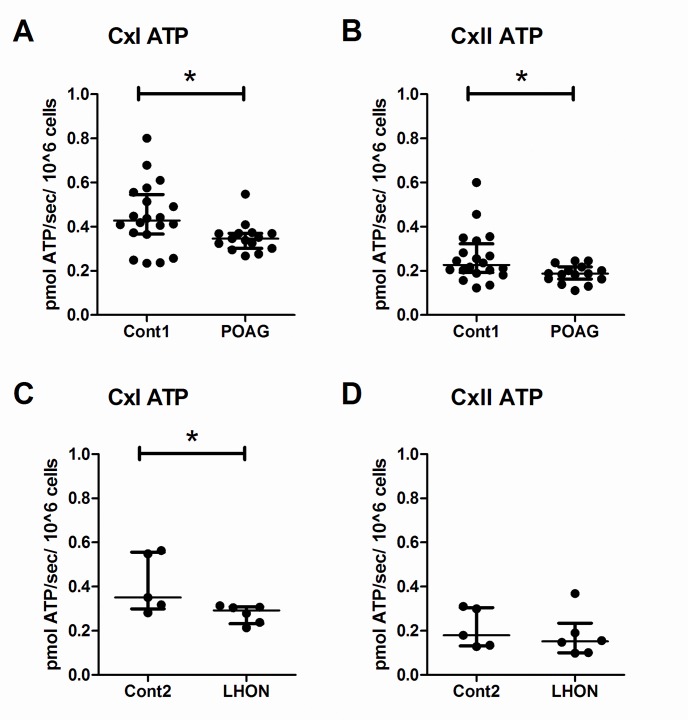
Impaired ATP synthesis in POAG and LHON lymphoblasts.Digitonin-permeabilised lymphoblasts from POAG, LHON and control patients were used to measure maximal ATP synthesis by mitochondrial respiration. There was a significant decrease in complex-I (glutamate + malate) driven ATP synthesis in both A) POAG and C) LHON lymphoblasts. There was a significant decrease in complex-II (succinate + rotenone) driven ATP synthesis in B) POAG lymphoblasts, but not in D) LHON lymphoblasts. Data is median (IQR), Mann-Whitney test, n = 20 cont1, n = 15 POAG, n = 6 cont2 and n = 6 LHON, * = p< 0.05.